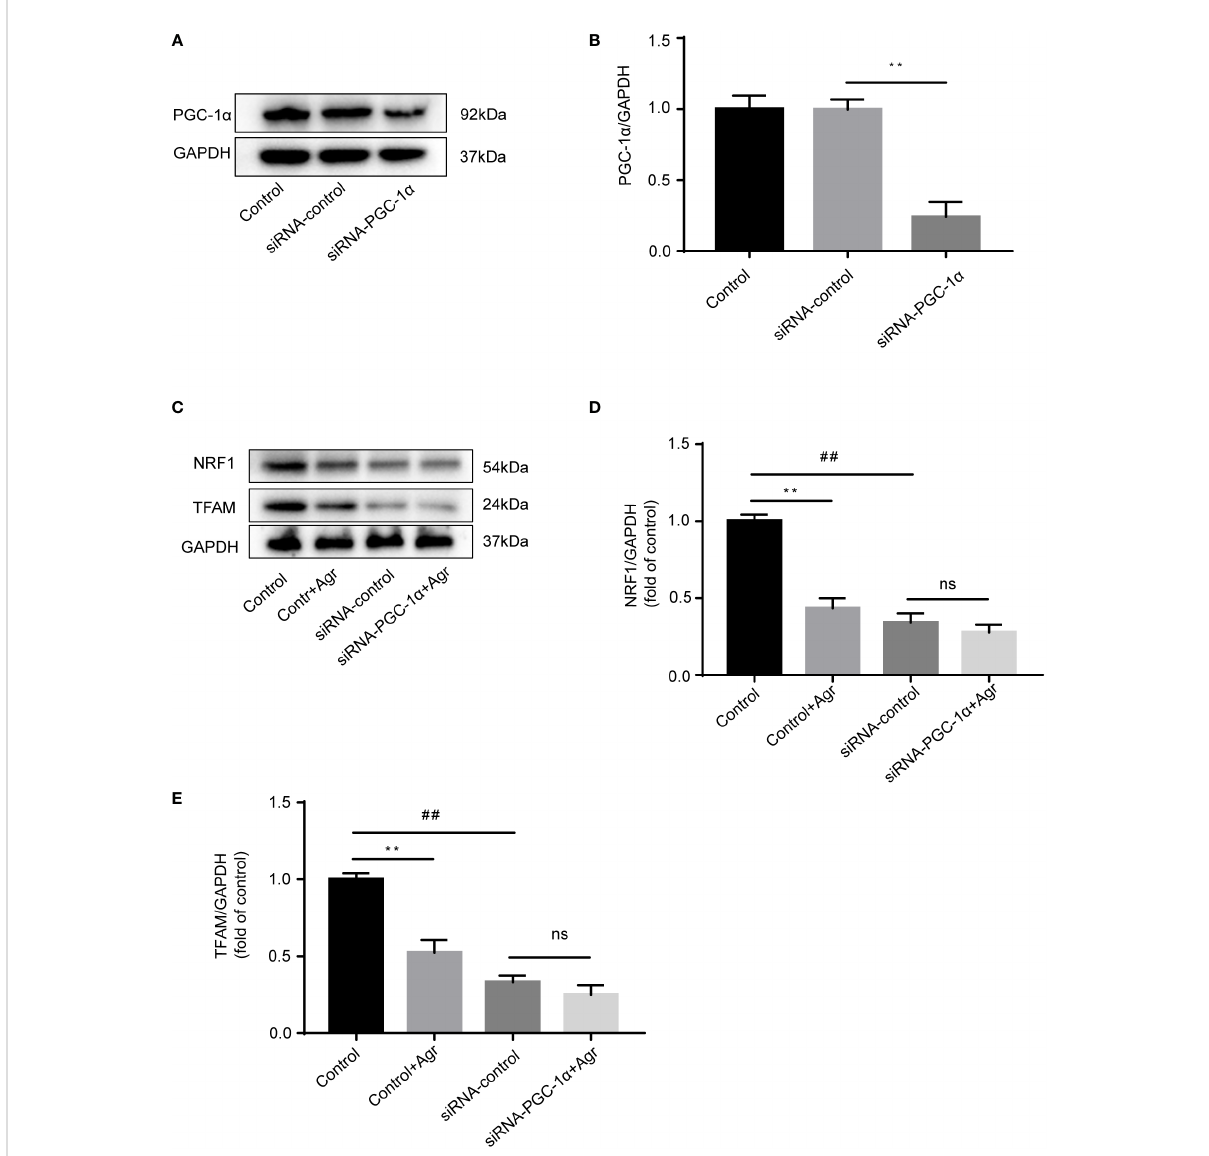
FIGURE 5 PGC-1 a knockdown to show the effects of Agr on NRF1 and TFAM expression in HCT116 cells. (A) After HCT116 cells were transfected with adenovirus vector-based siRNA targeting the PGC-1 a gene, PGC-1 a protein levels were analyzed using Western blotting analysis. (B) Quantitative data for the ratios of PGC-1 a to internal control protein (GAPDH). ** p < 0.01, siRNA control versus siRNA-PGC-1 a . (C) After HCT116 cells (siRNA-PGC-1 a ) were treated with Agr (576 nM), protein levels of NRF1 and TFAM were analyzed using Western blotting analysis. (D) The protein levels of NRF1 were quanti fi ed using ImageJ. (E) The protein levels of TFAM were quanti fi ed using ImageJ. ** p < 0.01, control versus control-Agr. ## p < 0.01, control-Agr versus siRNA-control. ns = no signi fi cant difference, siRNA-control versus siRNA-PGC-1 a + Agr. The results are shown as mean ± SD ( n = 3, each group). PGC-1 a , peroxisome proliferator-activated receptor- g coactivator 1 a ; Agr, agrimol B; NRF1, nuclear respiratory factor 1; TFAM, mitochondria transcription factor